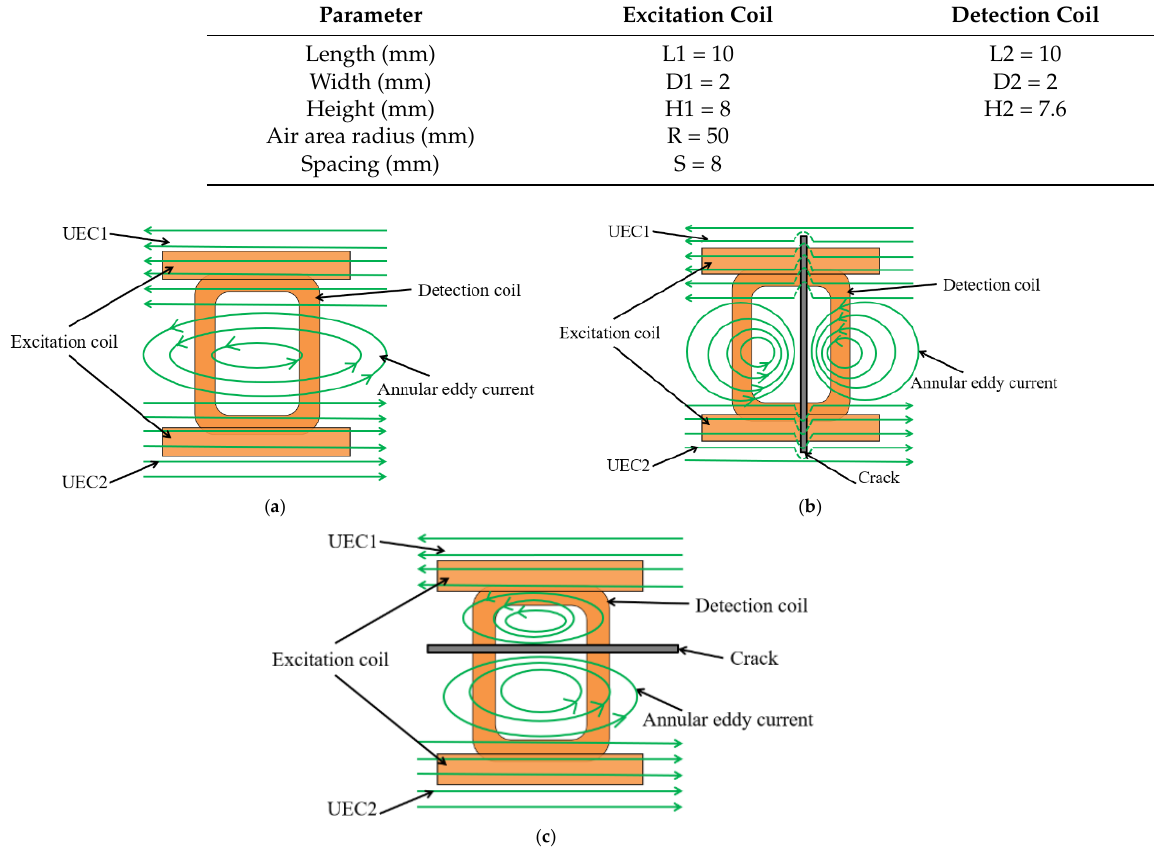
Figure 3. The detection schematic diagrams of the dual-excitation UEC probe: ( a ) no crack defect; ( b ) parallel crack defect; ( c ) vertical crack defect.